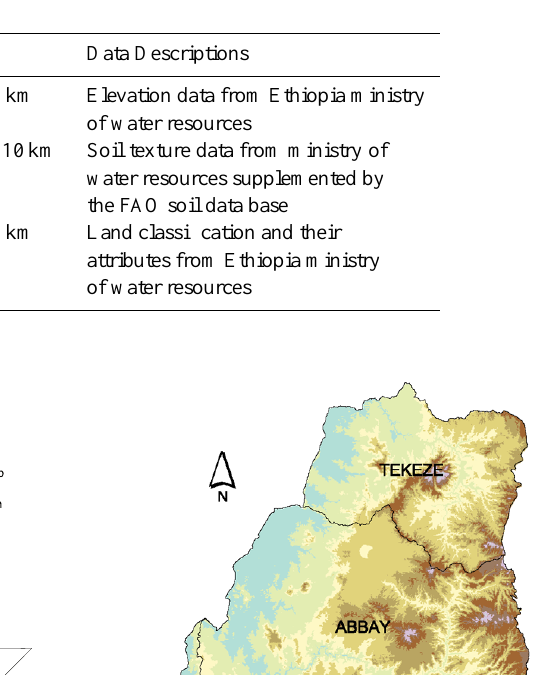
Table 1. Data sources for the Eastern Nile basin.